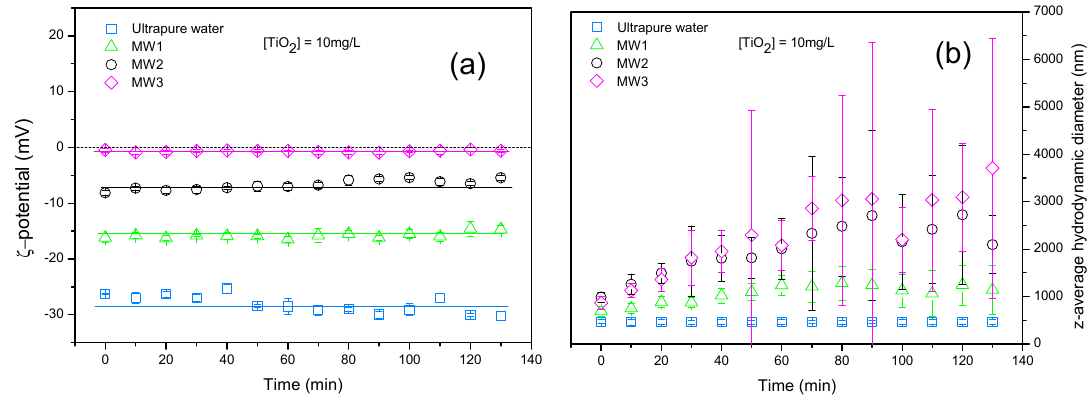
Figure 4. ( a ) ζ potential and ( b ) z-average hydrodynamic diameter variation of TiO 2 as a function of time in ultrapure water at pH = 7.0 ± 0.1 and mineral waters at their natural pHs. TiO 2 surface charge is found to be reduced and neutralized in mineral waters hence resulting in TiO 2 aggregation.